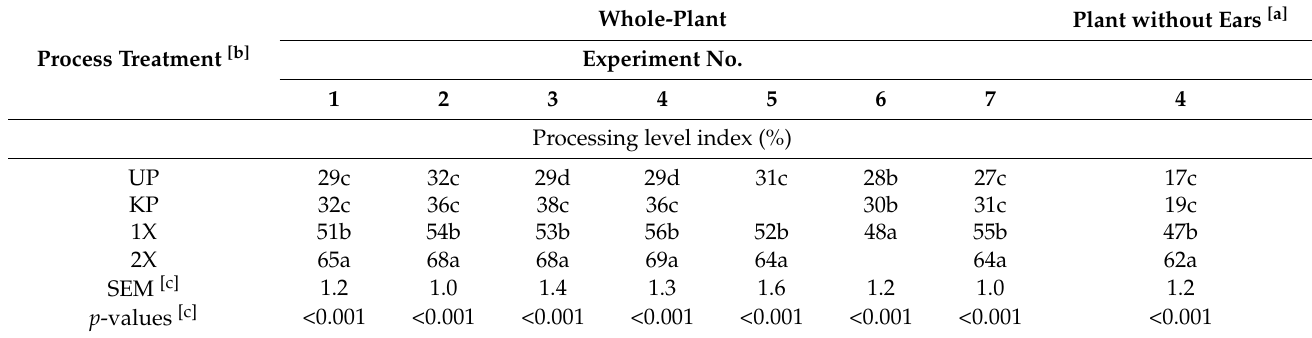
Table 2. Processing level index (PLI) for whole-plant corn or corn plants without ears.